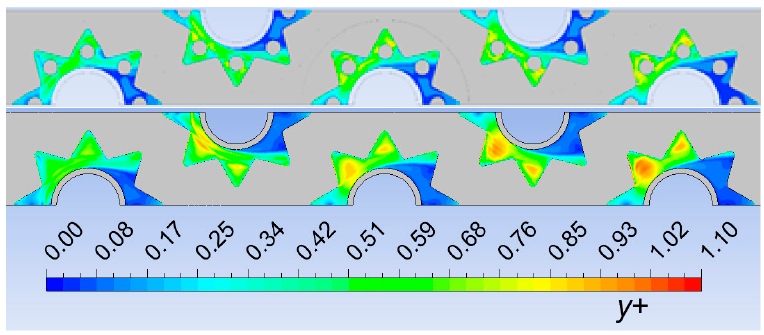
Figure 8. Turbulence kinetic energy fields for perforated and non ‐ perforated fins.